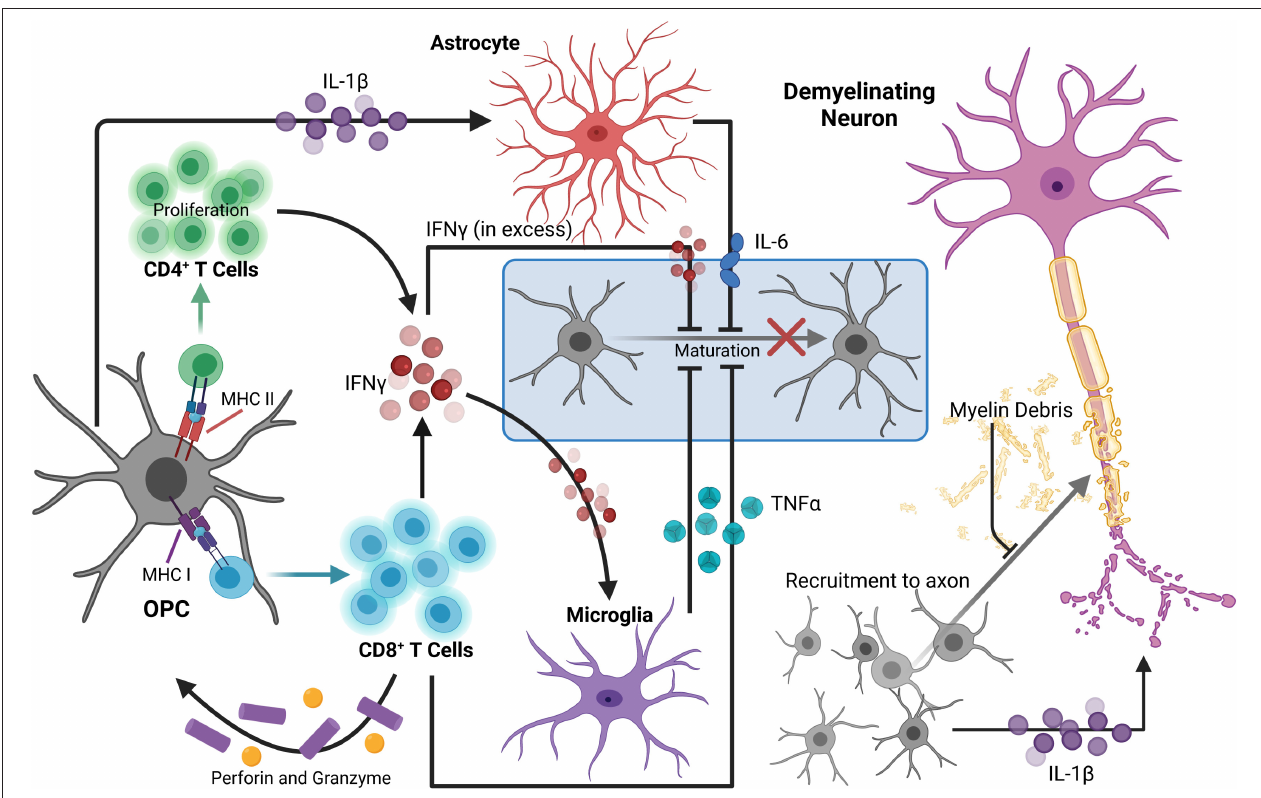
FIGURE 1 | OPCs contribute to the perpetuation of inflammation, leading to enhanced neurodegeneration in MS. During neuroinflammation, IFN γ can upregulate both MHC I and II antigen presentation molecules on OPCs to promote functional antigen presentation to CD4 + and CD8 + T cells, respectively. The antigen-MHC I complex can then induce TNF α and IFN γ expression by CD8 + T cells, as well as perforin and granzyme secretion, which can contribute to localized OPC cell death. OPCs also promote proliferation of and cytokine production by CD4 + memory and effector T cells via MHC II antigen presentation. TNF α produced by microglia in response to IFN γ signaling by T lymphocytes can also impair OPC differentiation. Excess extracellular IFN γ is associated with inhibition of OPC maturation and oligodendrocyte cell death. OPC expression of IL-1 β is also increased by IFN γ signaling, and stimulates IL-6 production by astrocytes, which can directly reduce OPC differentiation capacity. IL-1 β produced by OPCs may also contribute to neuronal cytotoxicity directly by enhancing cytotoxic glutamatergic synaptic transmission. Myelin debris from degenerating myelin sheathes repel OPCs, inhibiting recruitment and maturation. Taken together, in a neuroinflammatory state, there are many barriers limiting axonal support, repair, and remyelination by OL lineage cells that are perpetuated by OPCs themselves. Created with